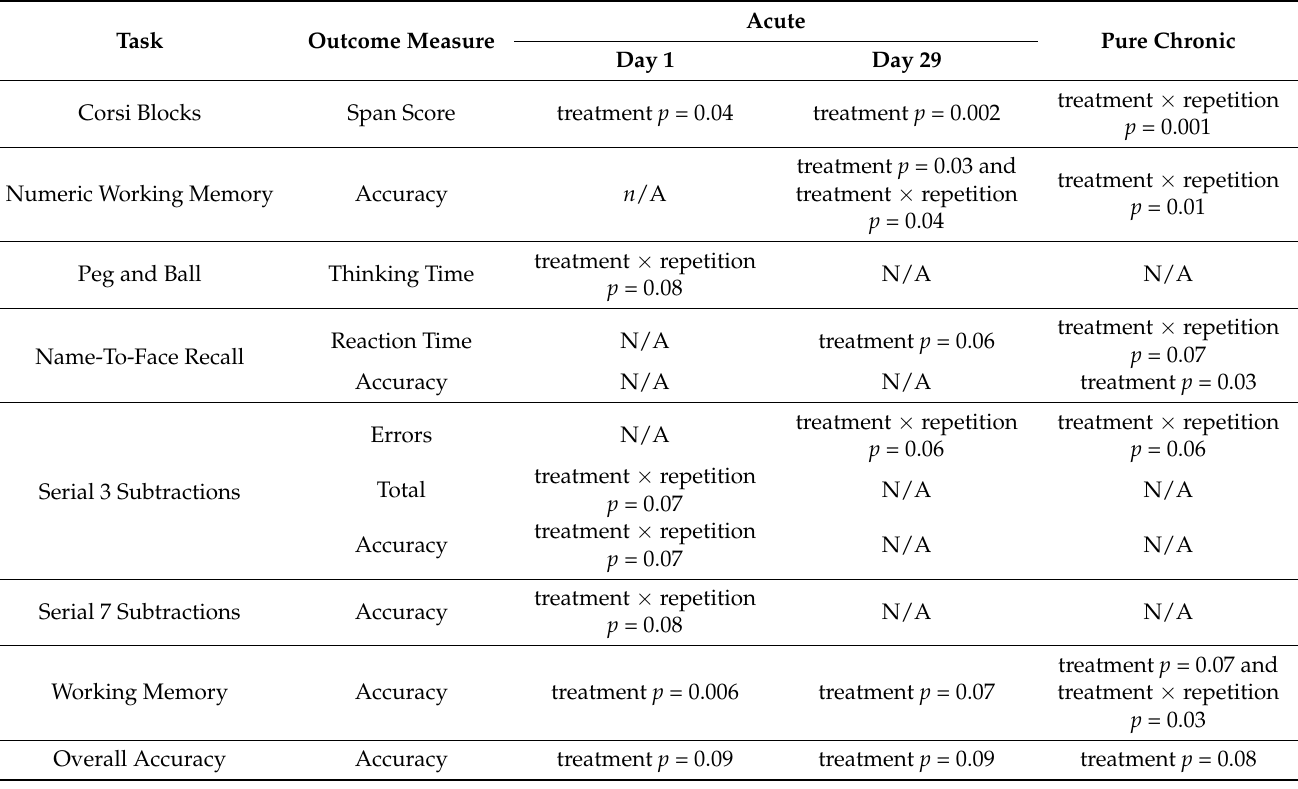
Table 3. Summary of cognitive effects of